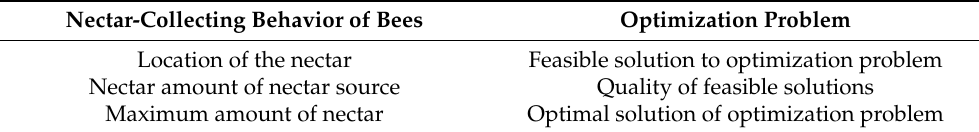
Table 2. Correspondence between honey collection behavior and optimization problem.